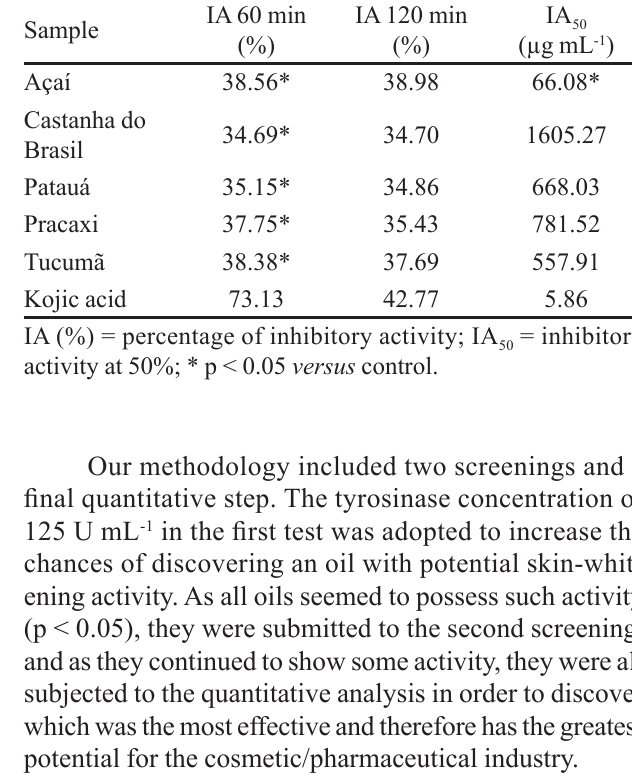
TABLE I - Tyrosinase inhibitory activity of oils from the Amazon